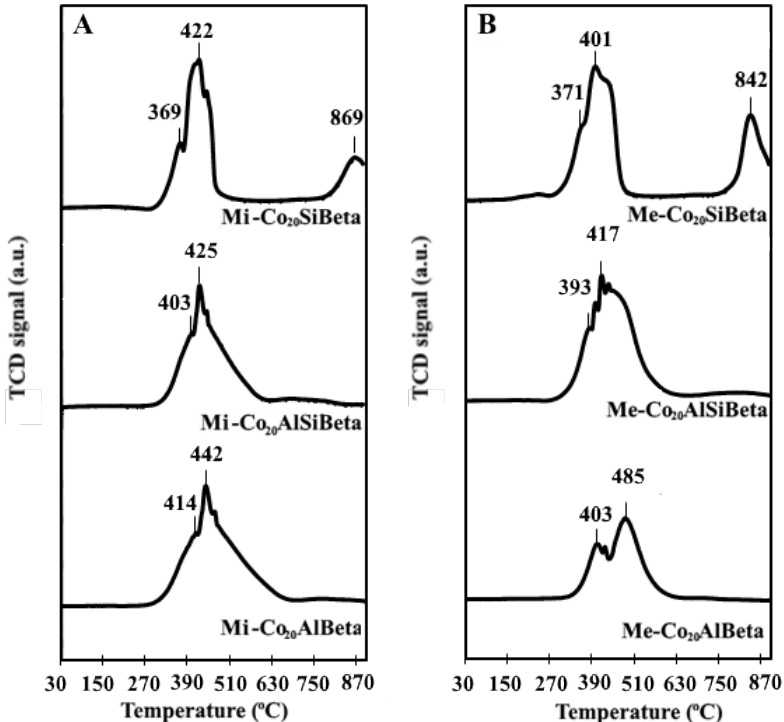
Figure 7. TPR-H 2 profiles of microporous Mi-Co 20 Beta ( A ) and mesoporous Me-Co 20 Beta zeolites ( B ).